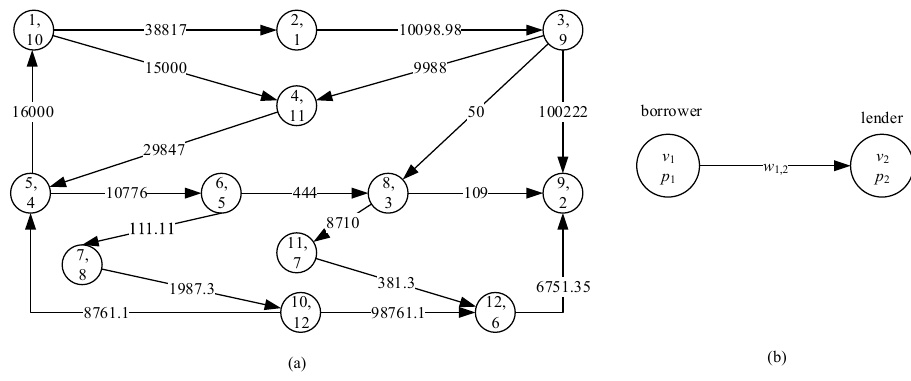
Figure 1. An example of debt graph. ( a ) A debt graph; ( b ) legend.